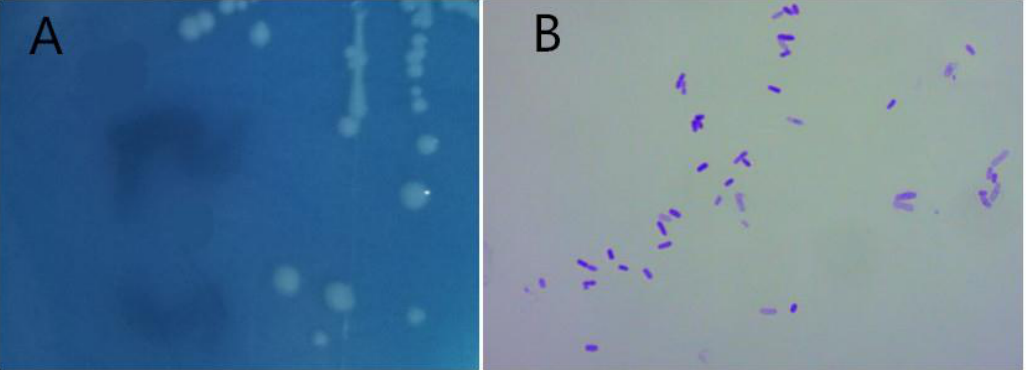
Figure 1. The morphologies characteristics of the strain D51. Single colony morphological characteristic on bromothymol blue (BTB) solid plates ( A ) and unicellular morphological feature of strain D51 (10 × 100) ( B ). Table 1. The results of the specific phospholipid fatty acid (PLFA) identification for strain D51. Library